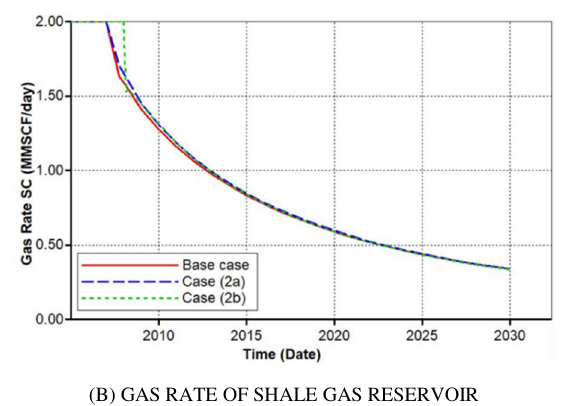
FIG.E 4. EFFECT OF FRACTURE